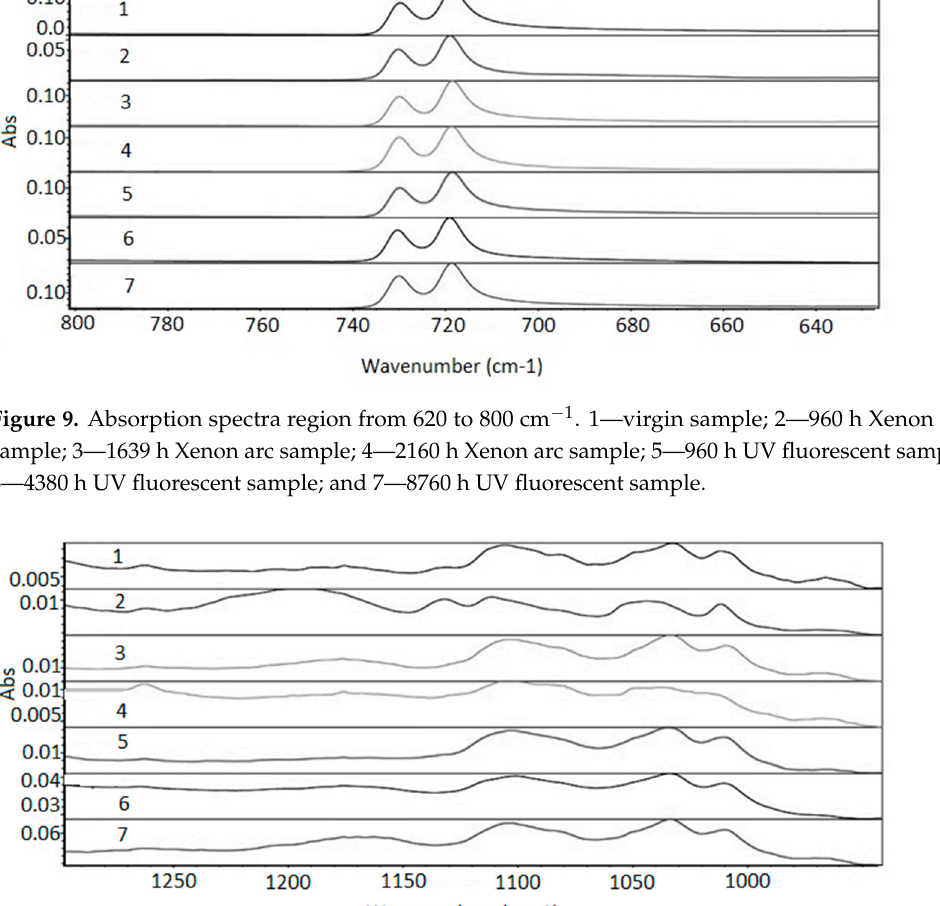
Figure 8. Absorption spectra region from 1420 to 1500 cm − 1 . 1—virgin sample; 2—960 h Xenon arc sample; 3—1639 h Xenon arc sample; 4—2160 h Xenon arc sample; 5—960 h UV fluorescent sample; 6—4380 h UV fluorescent sample; and 7—8760 h UV fluorescent sample.